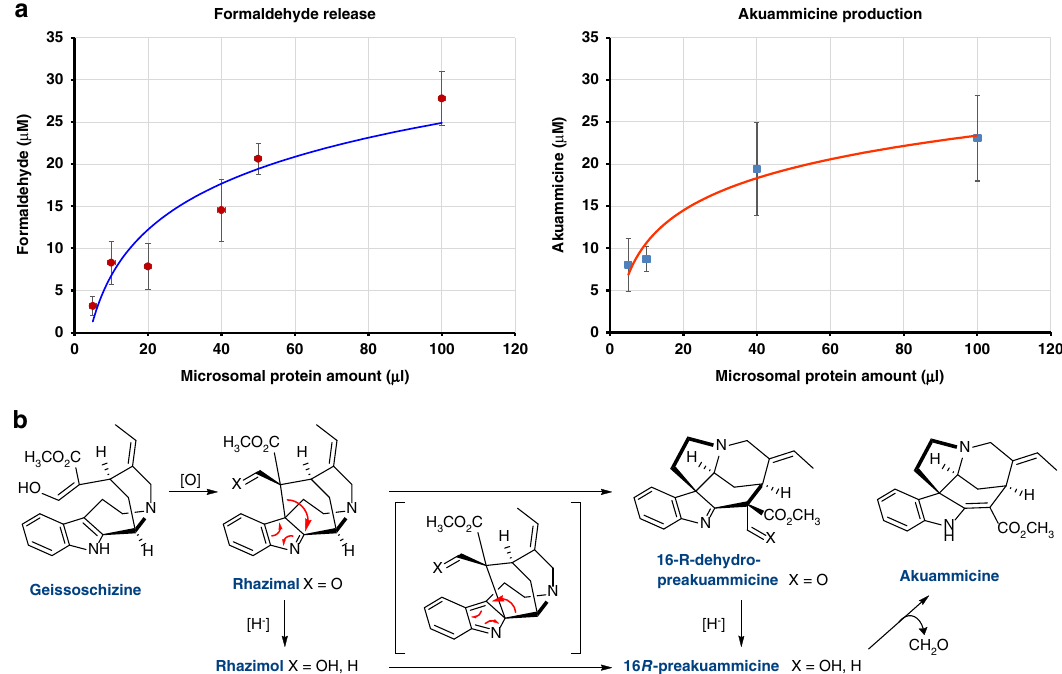
Fig. 4 Deformylation in the formation of akuammicine. a Deformylation as measured with Nash reagent correlates with akuammicine production as measured by mass spectrometry (see also Supplementary Figs 27 – 29). b Possible mechanistic scenario for rearrangement of geissoschizine to the preakuammicine skeleton as suggested by Benayad et al . 10 . Error bars represent standard error of three